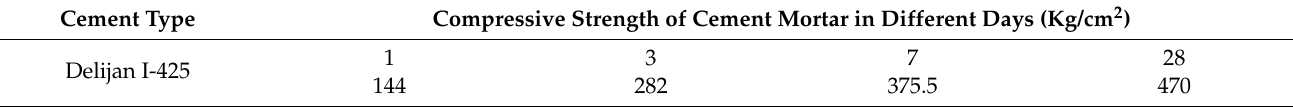
Table 4. Mechanical properties of cement mortar.